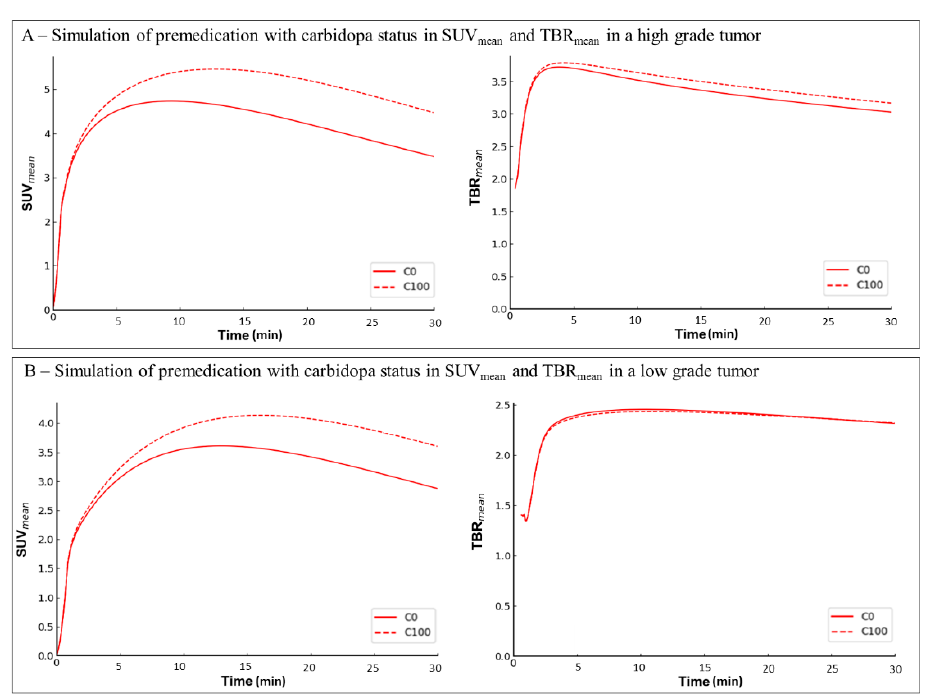
Figure 3. Typical examples of patients without carbidopa premedication (C0) simulated with the effects of 100 mg carbidopa premedication (C100). ( A ) 18 F-FDOPA PET time-activity curves expressed as SUV mean (left panel) of a 59-year-old woman with IDH wildtype glioblastoma. Carbidopa induces a longer TTP (TTP C0 = 9 mn; TTP C100 = 12.8 mn) and a higher slope (slope C0 = − 4 SUV/h; SUV C100 = − 3.1 SUV/h). 18 F-FDOPA PET time-activity curves expressed in TBR mean (right panel). The differences of TTP and slope values between carbidopa statuses are reduced when using Tumor-to-normal-Brain ratio (TBR) images (TTP C0 = 3.8 mn vs. TTP C100 = 4.2 mn; slope C0 = − 1.45 SUV/h vs. slope C100 = − 1.4 SUV/h); ( B ) 18 F-FDOPA PET time-activity curves expressed as SUV mean (left panel) of a 65-year-old man with oligodendroglioma. Carbidopa induces a longer TTP (TTP C0 = 13.6 mn; TTP C100 = 17.2 mn) and a higher slope (slope C0 = − 0.7 SUV/h; SUV C100 = − 0.3 SUV/h). 18 F-FDOPA PET time-activity curves expressed as TBR mean (right panel). The differences of TTP and slope values between carbidopa statuses are reduced when using Tumor-to-normal-Brain ratio (TBR) images (TTP C0 = 10.4 mn vs. TTP C100 = 11 mn; slope C0 = − 0.45 SUV/h vs. slope C100 = − 0.4 SUV/h).